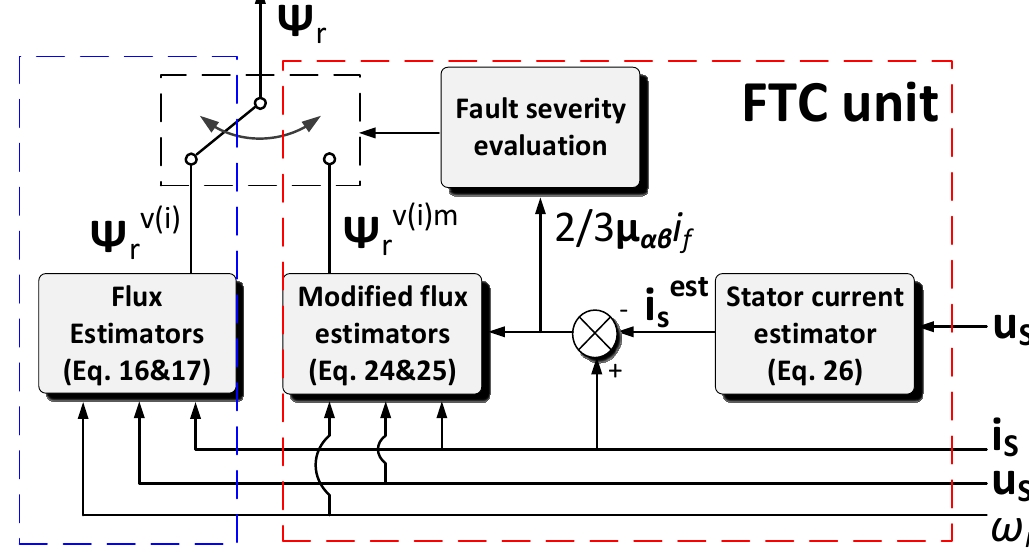
Figure 8. Schematic diagram of proposed new fault-tolerant control (FTC) system.